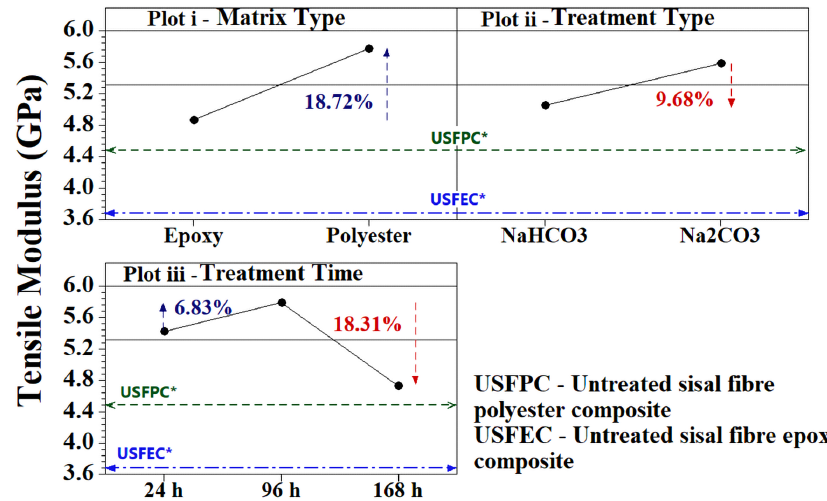
Figure 2. Main effect plots for the mean tensile modulus.